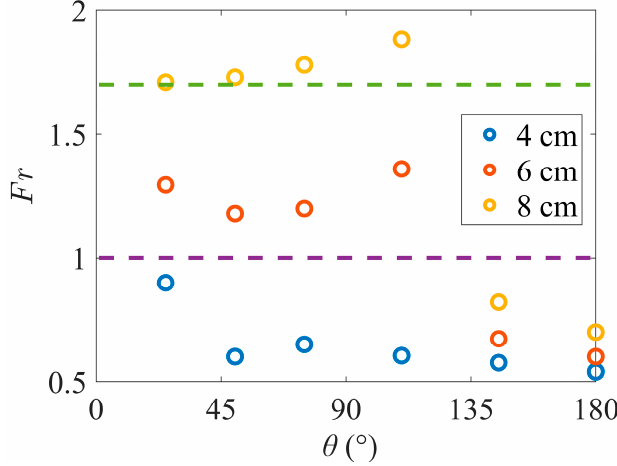
Figure 8. Maximum Froude number for each run (green and purple lines represent critical numbers Fr = 1.7 and = 1 ).